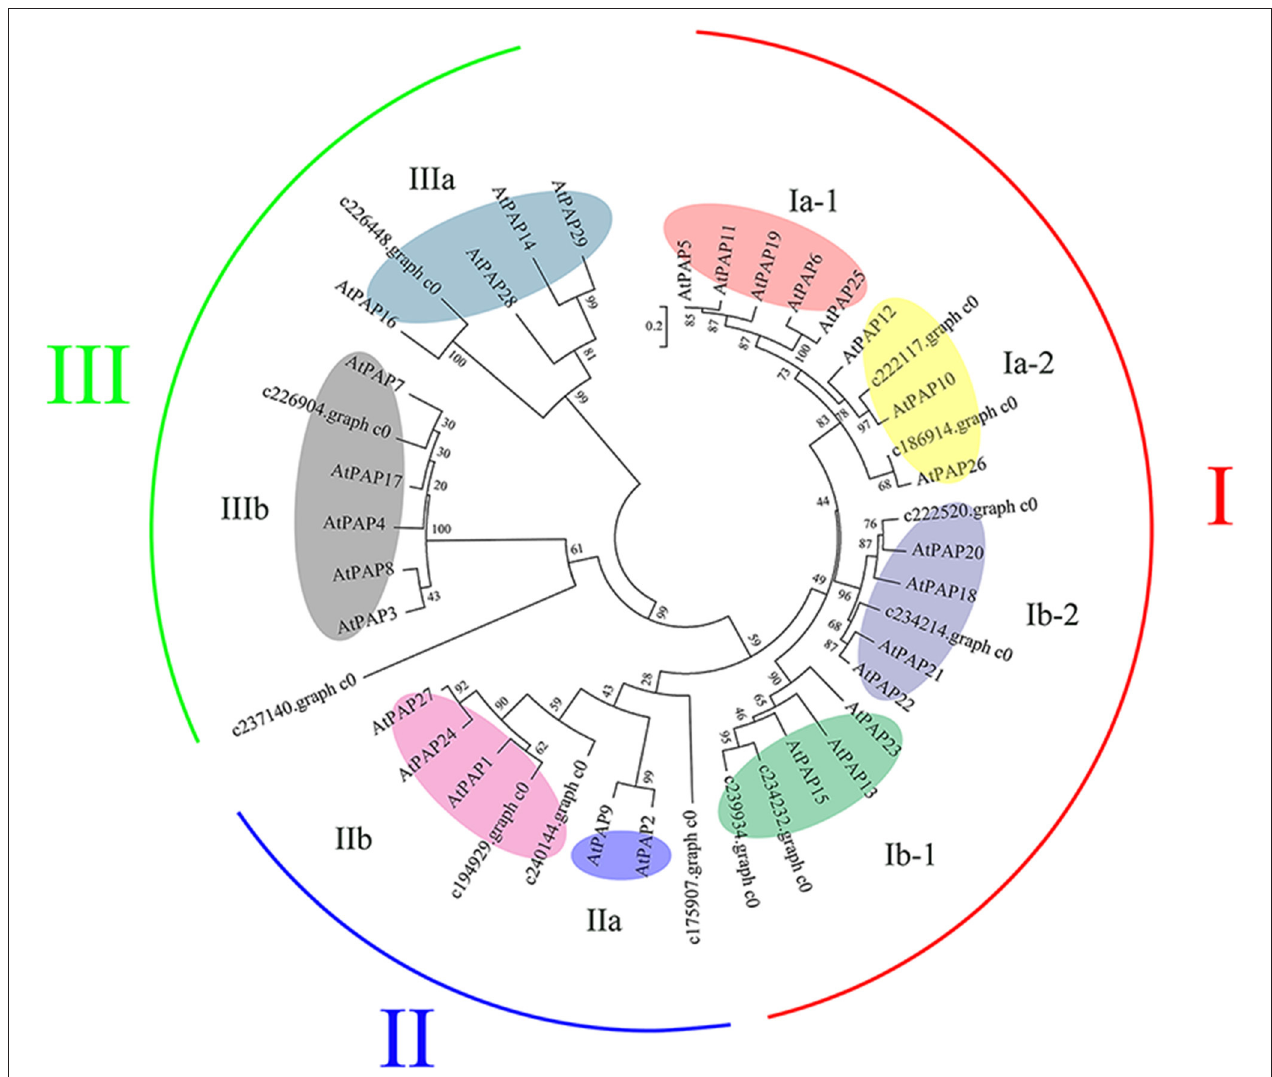
FIGURE 6 | Phylogenetic tree constructed of Zx PAP and At PAP proteins. A neighbor-joining phylogenetic tree was constructed using Mega 6.0, through the multiple sequence alignment of PAP family amino acid sequences from Arabidopsis thaliana ( At ) and Zygophyllum xanthoxylum ( Zx ). Bootstrap values are percentages of 1,000 replications. The main groups (groups I, II, and III) were further divided to yield eight subgroups (colored elipses). The GenBank accession numbers of A. thaliana represented in the phylogenetic tree are as follows: At PAP1: NP_172830.1; At PAP2: OAP14841.1; At PAP3: AEE29210.1; At PAP4: AAW29946.1; At PAP5: AEE32870.2; At PAP6: AEE33383.1; At PAP7: AEC05511.1; At PAP8: NP_178298.2; At PAP9: AEC05701.1; At PAP10: NP_179235.1; At PAP11: AEC06729.1; At PAP12: AEC07951.1; At PAP13: AEC08738.1; At PAP14: AEC10767.1; At PAP15: AEE74502.1; At PAP16: AEE74865.1; At PAP17: NP_566587.1; At PAP18: AEE76388.1; At PAP19: AEE78116.1; At PAP20: OAP01932.1; At PAP21: AEE78996.1; At PAP22: AEE78997.1; At PAP23: NP_193106.3; At PAP24: AEE84973.1; At PAP25: AEE86645.1; At PAP26: NP_198334.1; At PAP27: AED95939.1; At PAP28: AED96852.1; At PAP29: